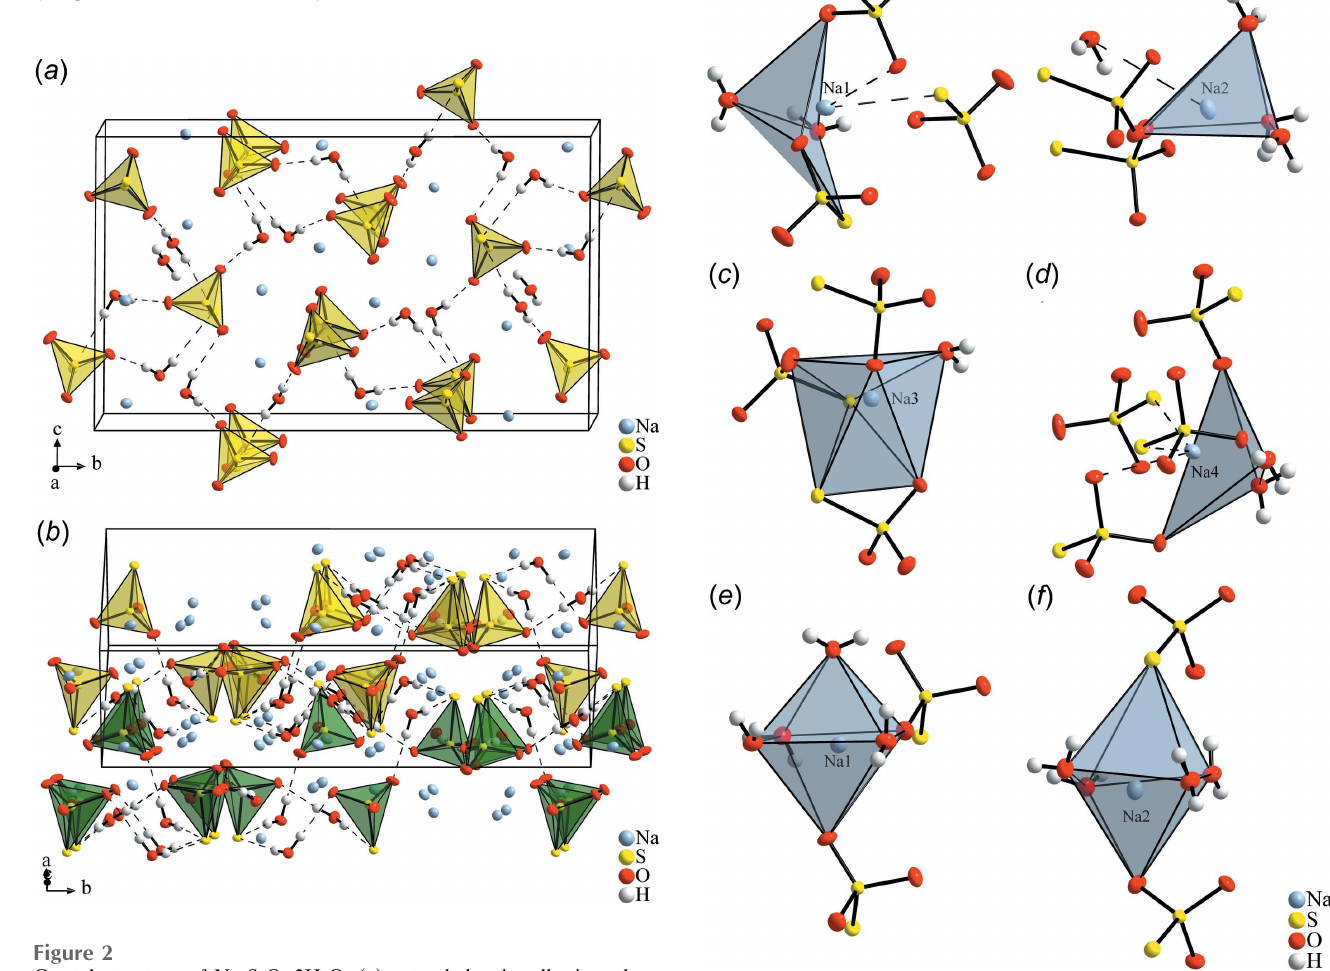
Figure 2 Crystal structure of Na 2 S 2 O 3 (cid:2) 2H 2 O: ( a ) extended unit cell, view along [ 100]; ( b ) section of two layers of S 2 O 32 (cid:5) anions and H 2 O molecules connected by hydrogen bonds, view along [101], differently coloured tetrahedra belong to different layers. Anisotropic displacement ellipsoids of non-H atoms are drawn with 80% probability, S 2 O 32 (cid:5) ions as tetrahedra, and hydrogen bonds as dashed